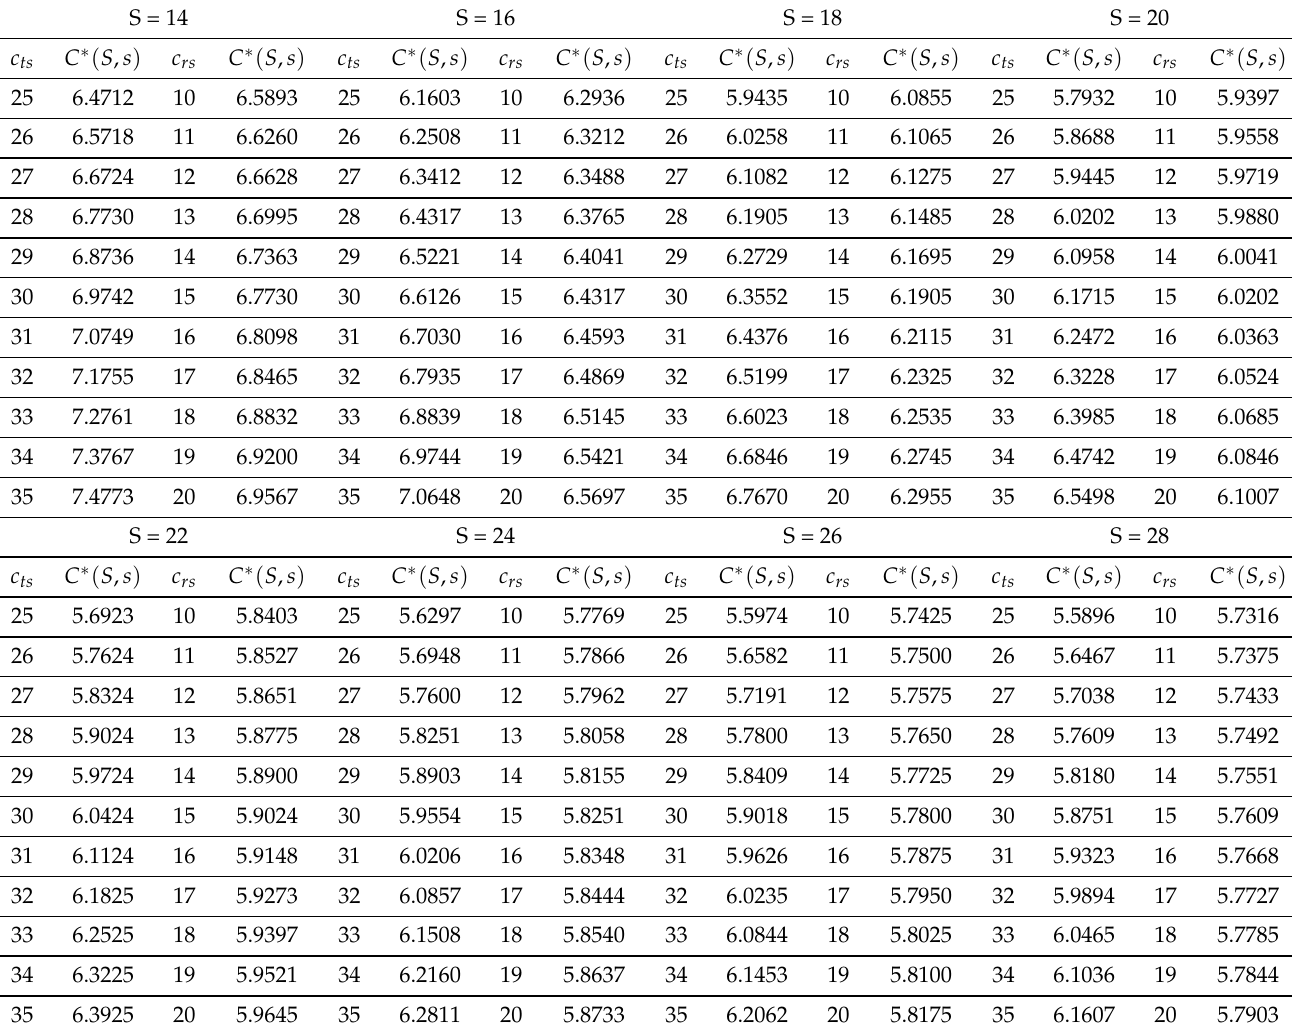
Table 3. The optimal cost value for different setup cost values of two